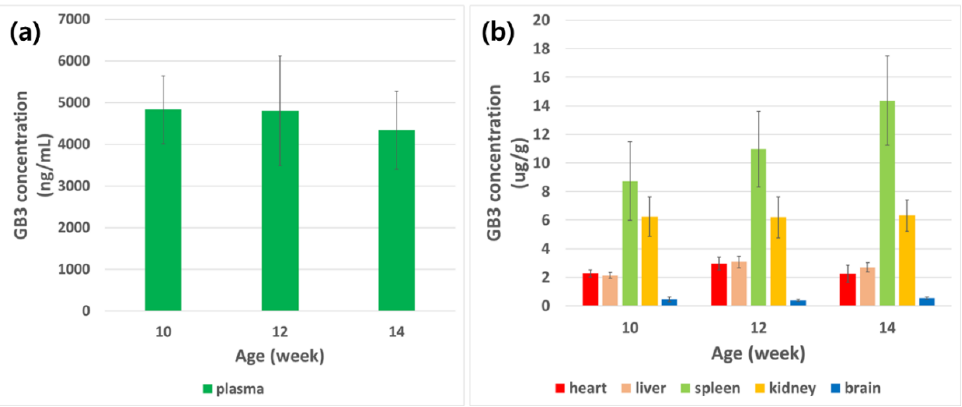
Figure 8. Age-related GB3 level changes in ( a ) plasma, and ( b ) tissues.